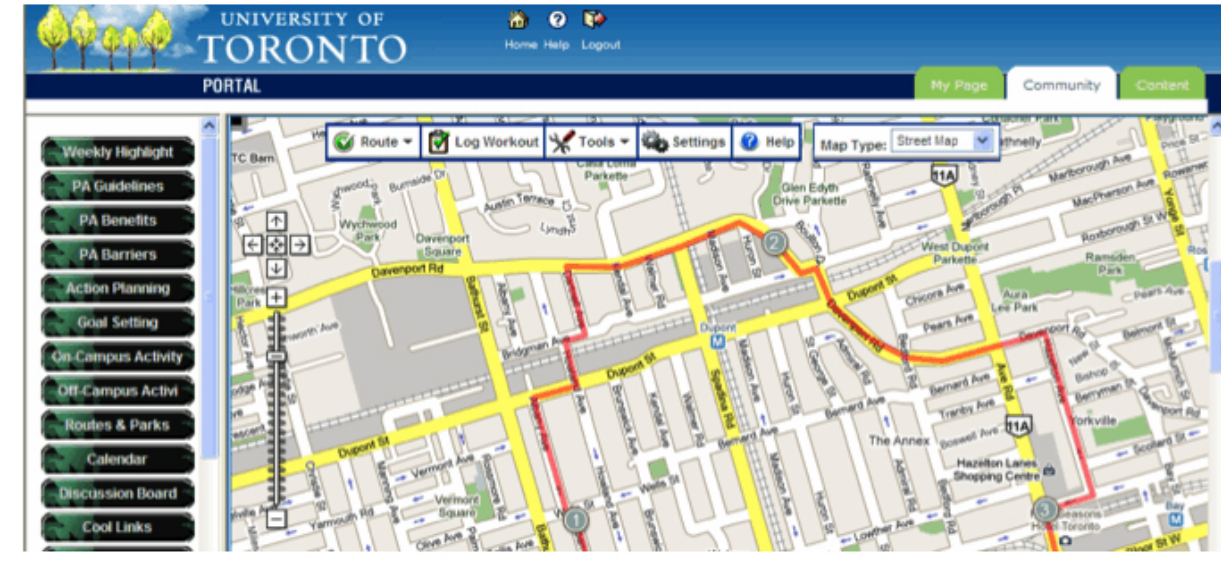
Figure 2. Screenshot of running map as example of intervention